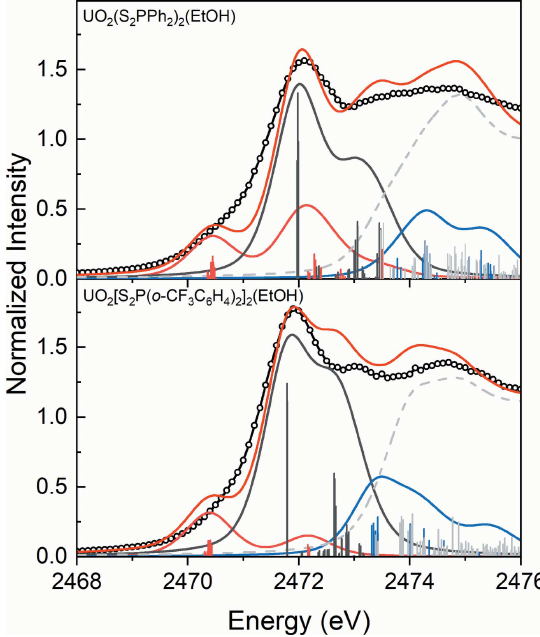
Figure 8 Comparison of the simulated spectra obtained by calculations (red) with the experimental S K -edge XAS data for UO 2 (S 2 P R 2 ) 2 (EtOH) (black). The purple, blue, orange and light gray bars represent the energies and oscillator strengths for the calculated transitions involving U 5 f , 6 d , C (cid:5) and S 2 P orbitals containing little S 3 p character without U 5 f or 6 d character,